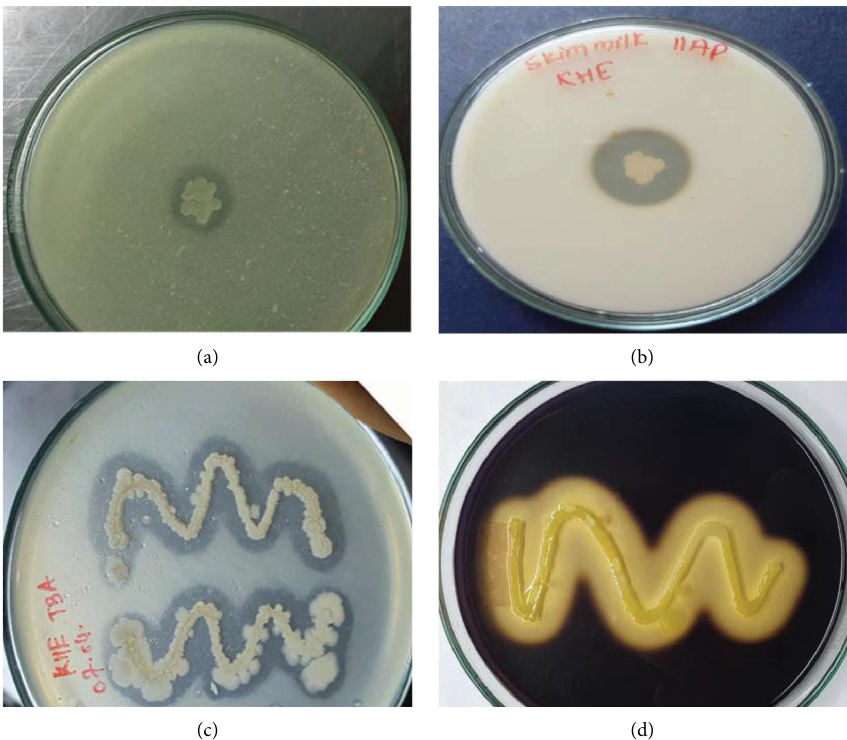
Figure 3: Hydrolytic enzymes production test for isolate BKHE: (a) alkaline protease screening in sodium caseinate agar (pH: 8); (b) protease screening in skim milk agar; (c) lipase screening in tributyrin agar; (d) amylase screening in starch agar.